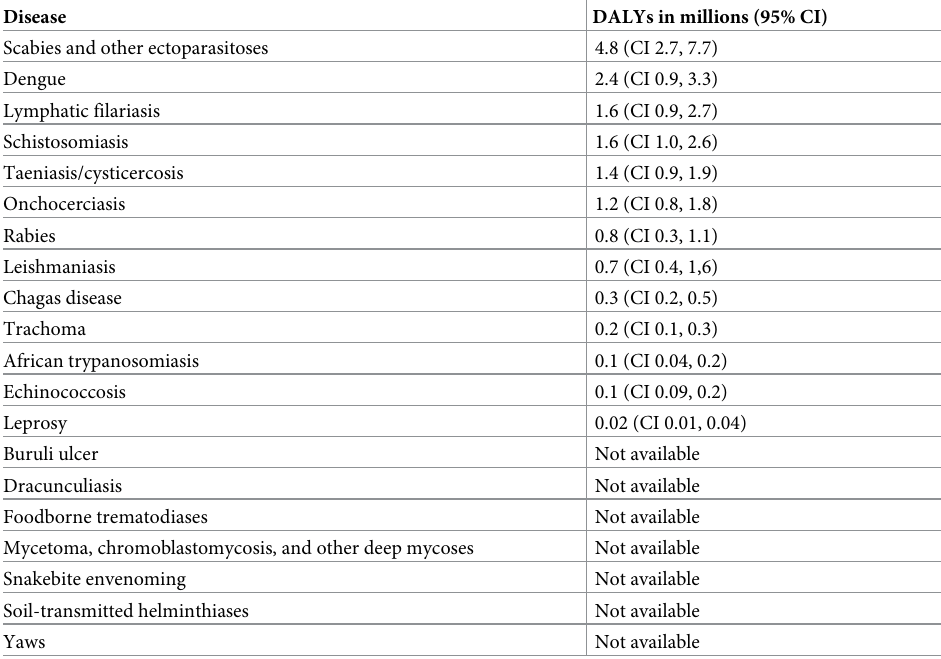
Table 2. DALYs from the 2019 Global Burden of Disease Study for WHO-recognized NTDs